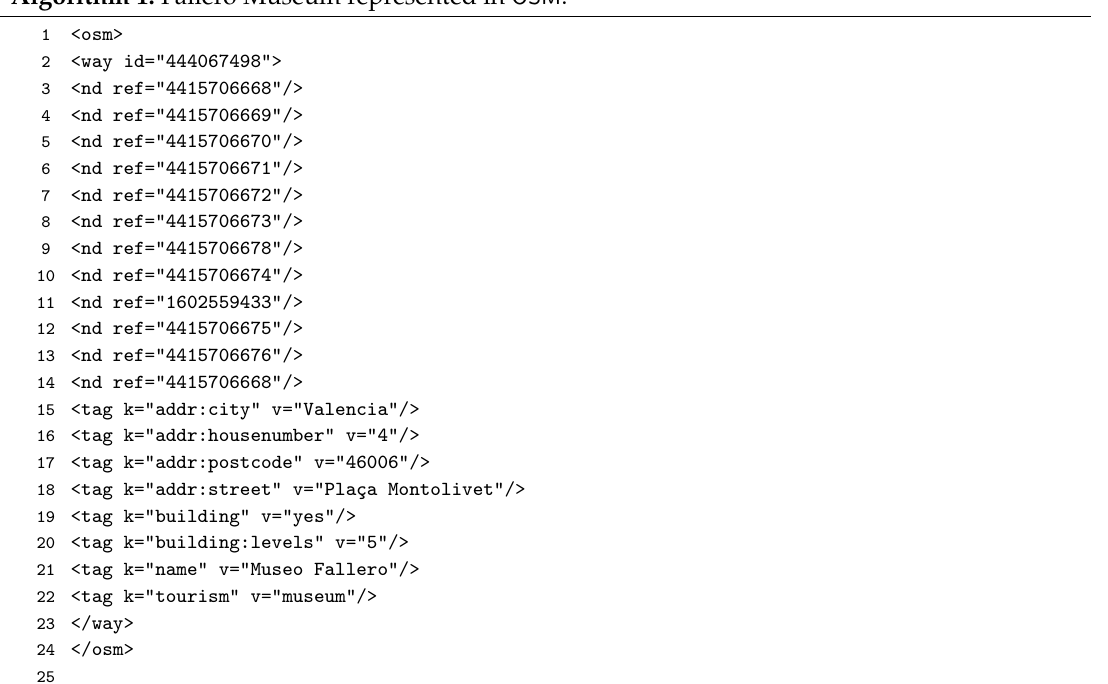
Algorithm 1: Fallero Museum represented in OSM . 1